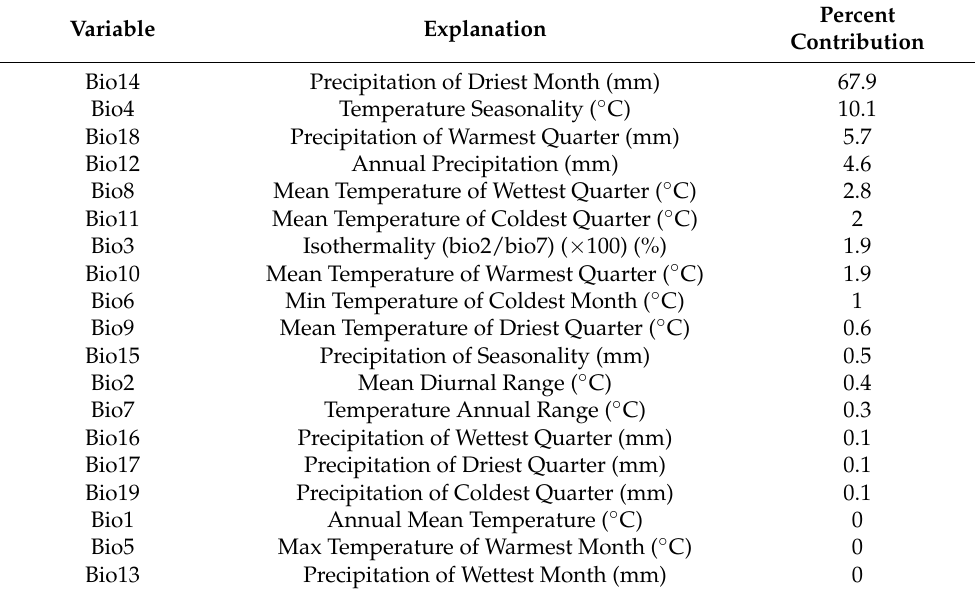
Table 1. The contribution of 19 climatic variables to the distribution of Acer cordatum Pax and ex- planations of each climatic variable.